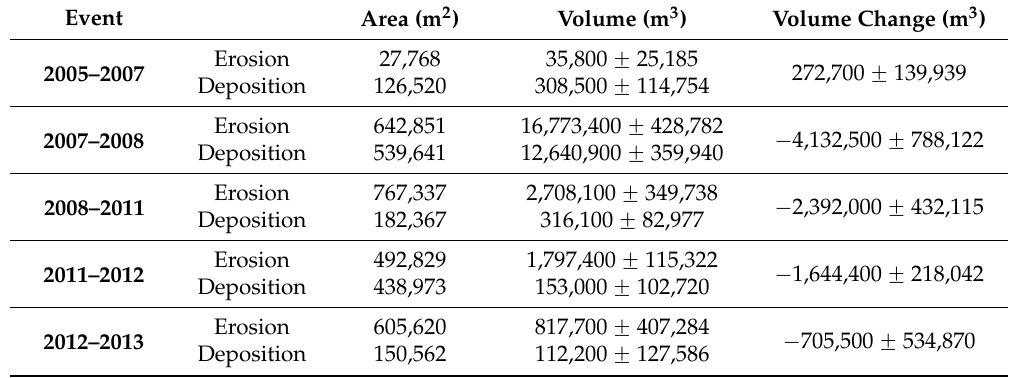
Table 5. Volumes of erosion, deposition, and volume change within the Meiyuan Shan landslide area estimated using digital terrain model (DTM) data obtained from multiple